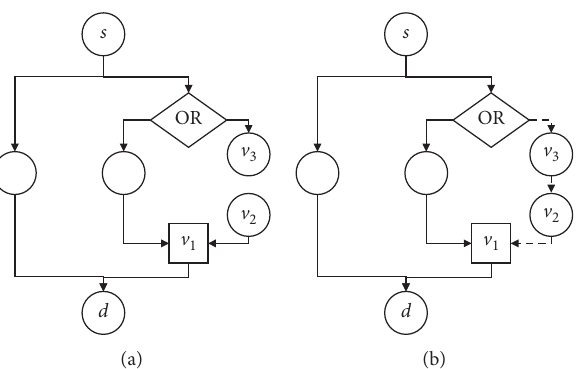
Figure 4: Algorithm 3 cuts off redundant branches of the OR node: (a) a full-linked network connecting s and d and (b) cut-off one branch of node